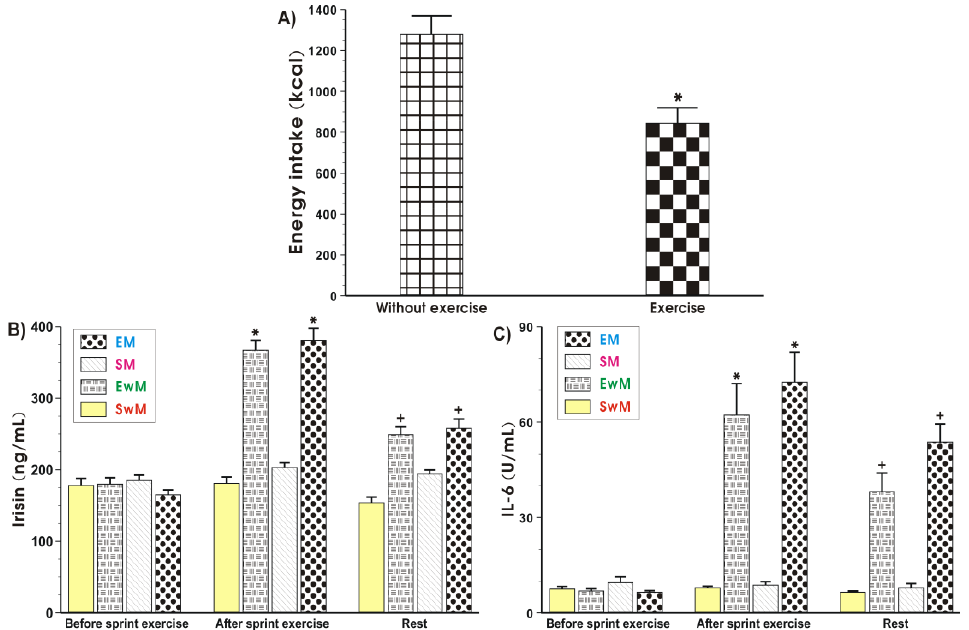
Figure 2. Energy intake at the test meal during exercise and resting sessions ( A ), and the plasma irisin ( B ) and IL-6 ( C ) levels determined at basal sedentary conditions and after the Wingate exercise in subjects with or without meal feeding. Values represent means ±SD for 26 subjects. Statistical analysis was done by paired t-Student test for data presented in Figure 2A. Asterisk indicates a significant decrease ( p < 0.05) as compared with values obtained in subjects without exercise. For data presented in Figure 2B, C, the statistical analysis was done by two-way repeated measures ANOVA and Tukey post hoc test. An asterisk indicates a significant increase ( p < 0.05) as compared with basal values. Cross indicates a significant decrease ( p < 0.05) as compared with respective values in groups EwM and EM before meal consumption. EM—the 30 s Wingate Test (W-T30) with ad libitum test meal intake, EwM—W-T30 without ad libitum test meal intake, SM—sedentary with ad libitum test meal intake, SwM—sedentary without ad libitum test meal intake.